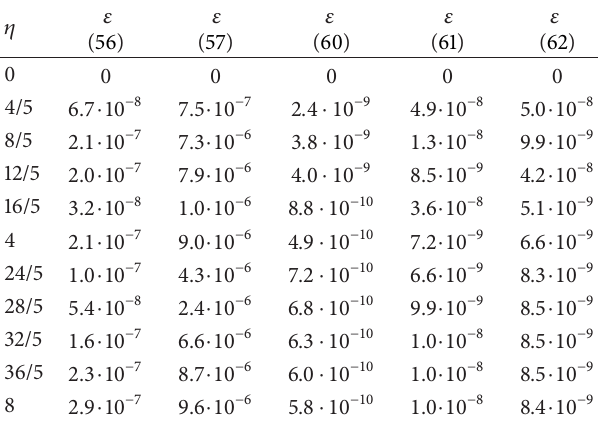
Table 8: Comparison of the first-order approximate solution 𝑓 obtained by OHAM with numerical results.